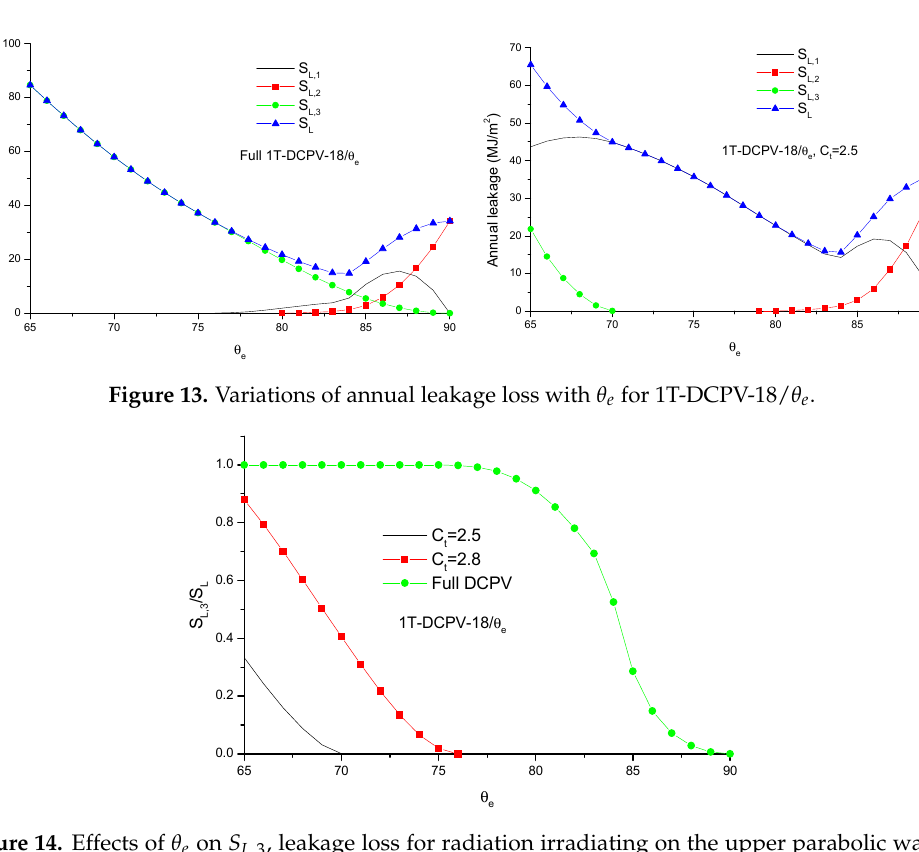
Figure 14. Effects of θ e on S L ,3 , leakage loss for radiation irradiating on the upper parabolic wall at θ a < θ p < θ p , c 2 Figure 14 . Effects of θ . , 2 pc